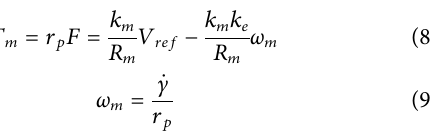
between the motor torque, Tm, reference voltage, V ref, and the linear force, F shown in Eq. 8 and Eq. 9 are utilized, where r p is the radius of the wheel or pulley, R m is the motor electrical resistance, T m is the DC motor torque, k m is and ω m is the motor angular velocity as described (Shehu et al., 2019).